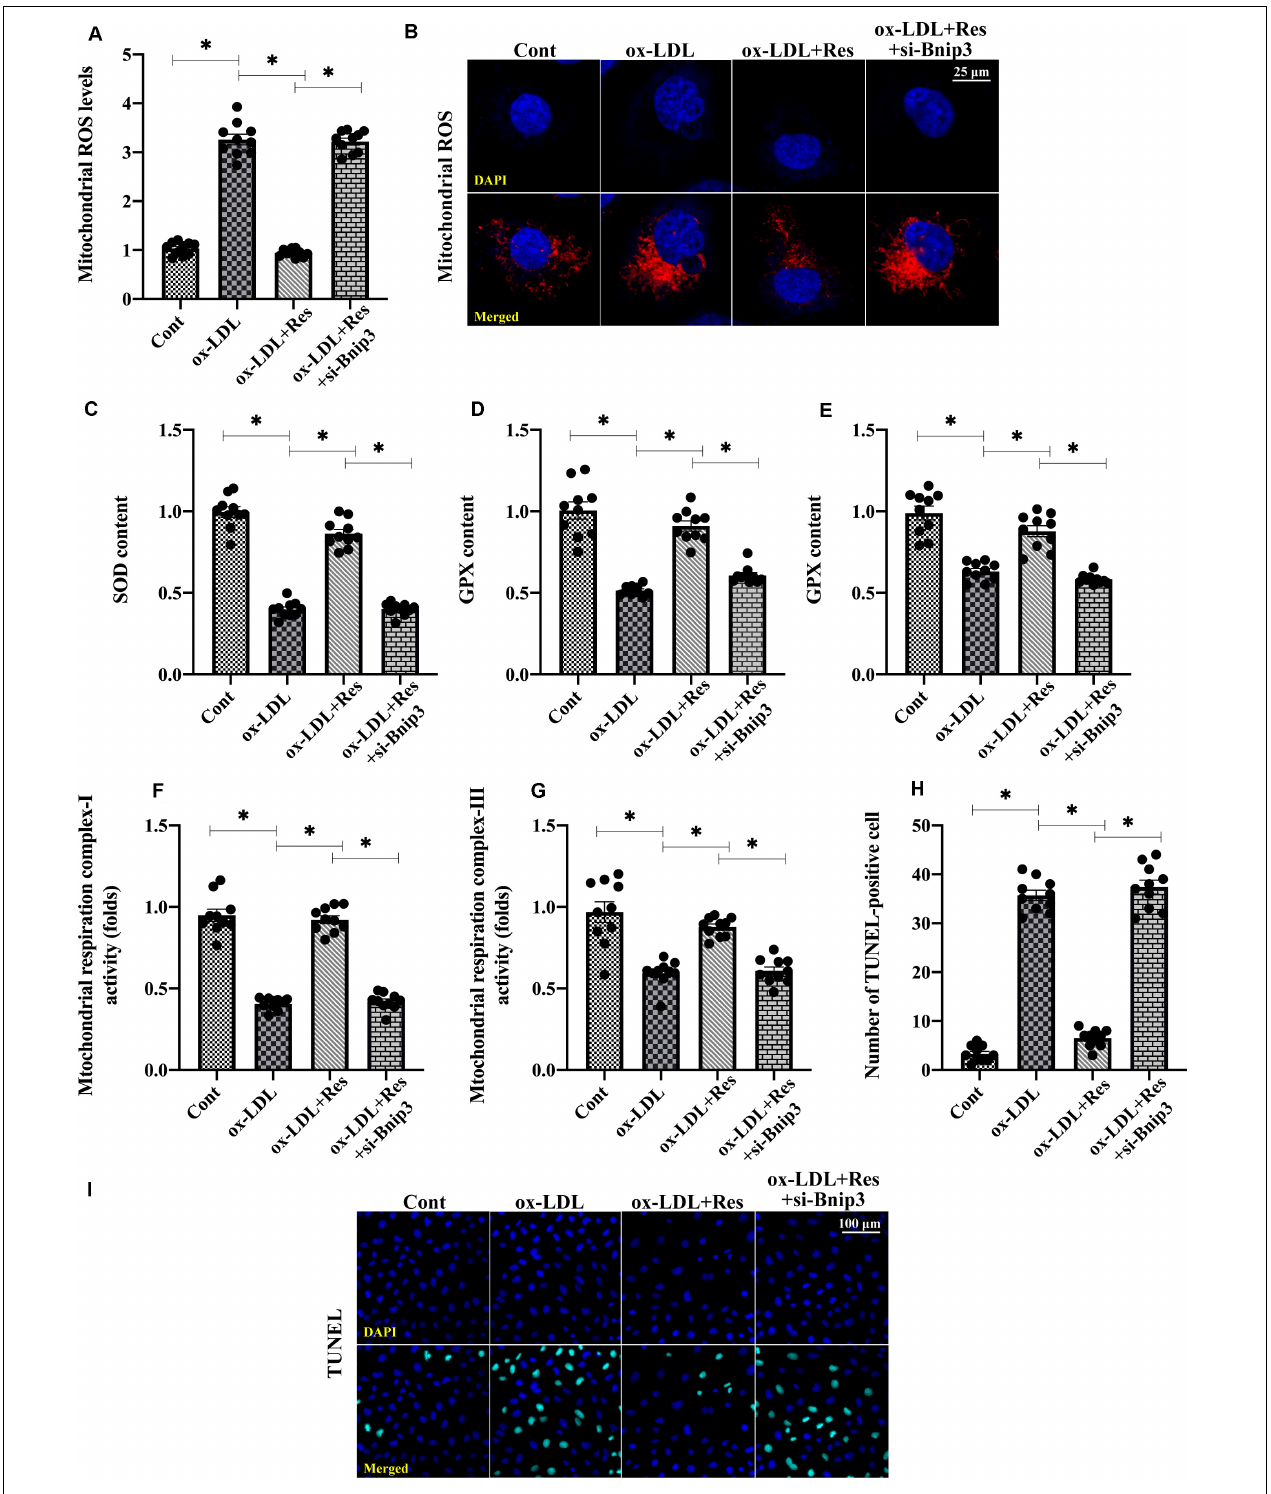
FIGURE 4 | Inhibition of Bnip3-related mitophagy suppresses resveratrol-induced protection on mitochondrial homeostasis. (A,B) Bnip3 siRNA was transfected into endothelial cells before treated with resveratrol. Then, mitochondrial ROS levels were measured through immunofluorescence. (C–E) ELISA was used to evaluate GSH, SOD, and GPX activity in endothelial cells. (F,G) Mitochondrial respiration complex I and III activities were measured through ELISA. (H,I) TUNEL staining was used to quantify apoptotic endothelial cells in response to Bnip3 knockdown. * p < 0.05.